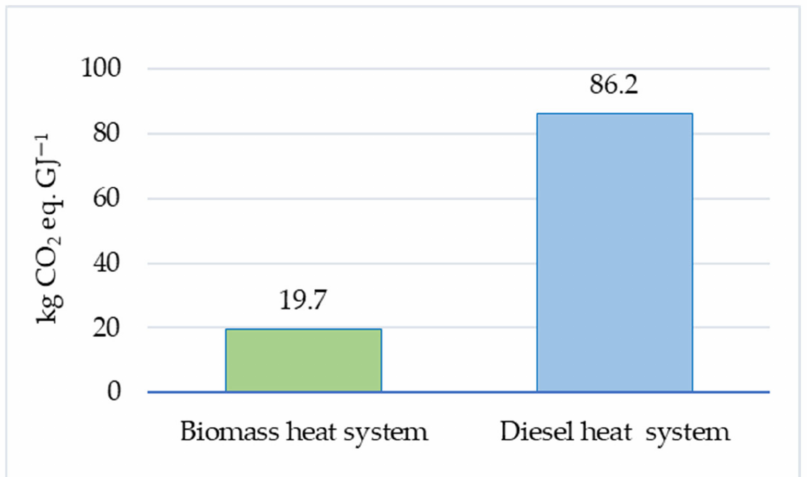
Figure 5. Comparison between the emissions (in kg CO 2 eq) generated by a biomass boiler connected to the less efficient biennial poplar supply chain and a diesel boiler to produce 1 GJ of thermal